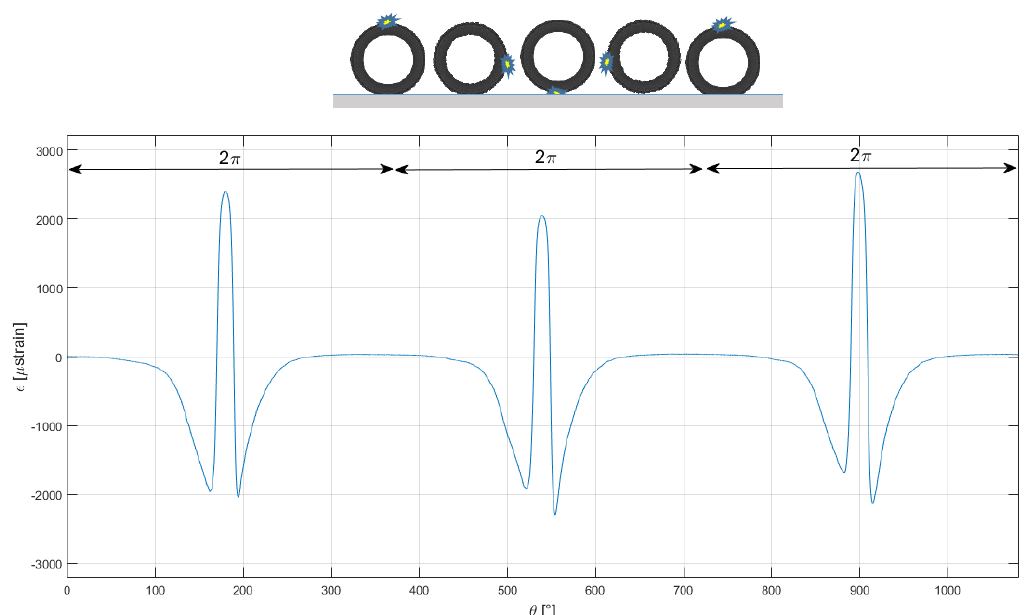
Figure 19. Plot of strain and FBG sensor position as function of the wheel rotation.